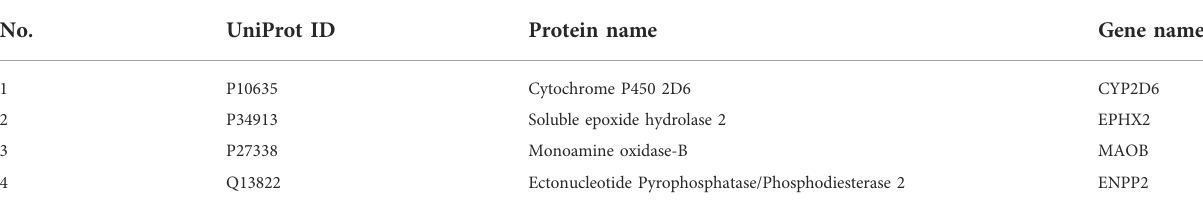
TABLE 2 The critical direct targets of RS-FZ for